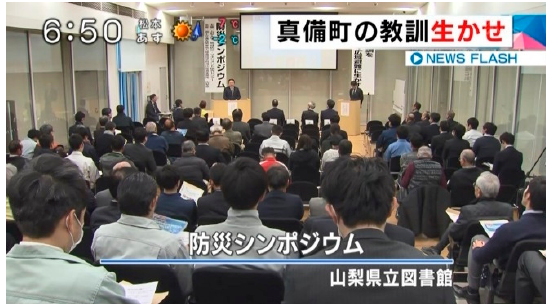
Figure 10. Disaster management symposium.